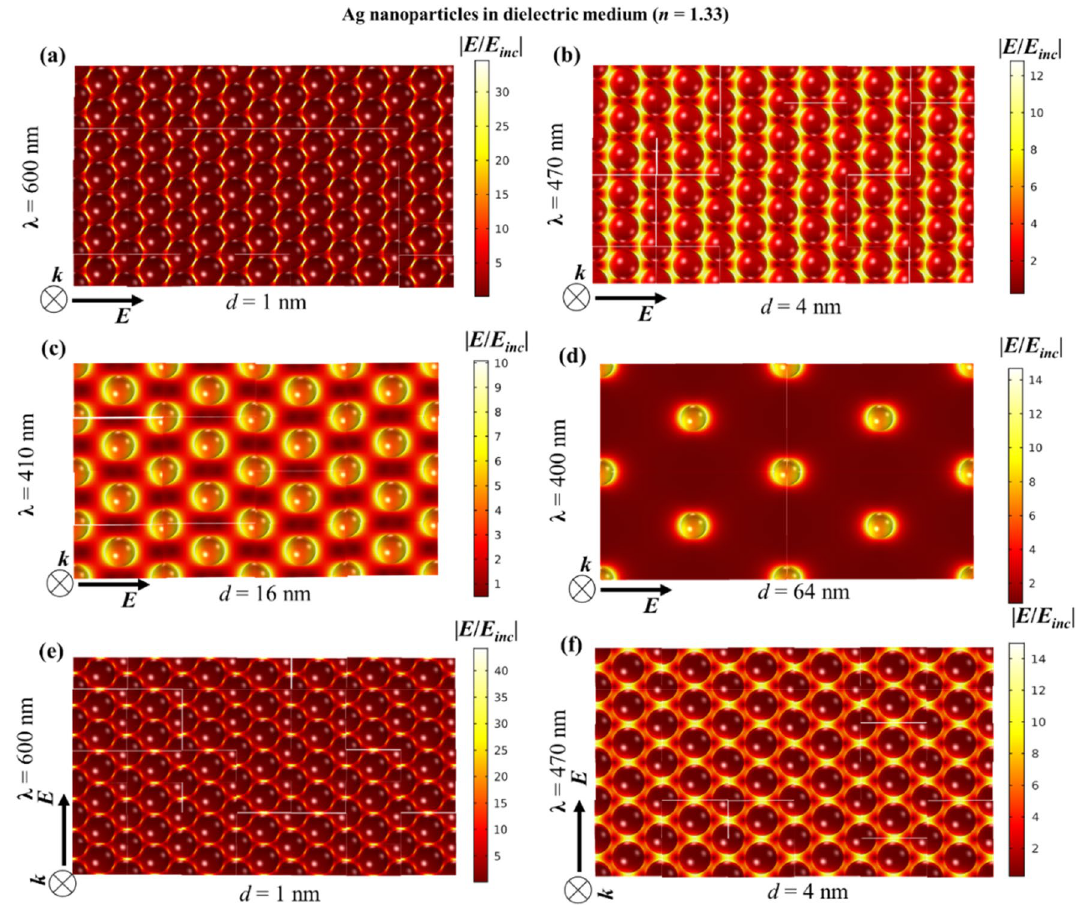
Figure 8. Near-field enhancement w.r.t. the incident field for 2D hexagonal monolayer array of 20 nm Ag nanoparticle in dielectric medium ( n = 1.33) for different interparticle gaps, d : ( a ) 1 nm, ( b ) 4 nm, ( c ) 16 nm and ( d ) 64 nm. ( e , f ) Shows the near-field profiles at vertical polarization for interparticle gaps 1 and 4 nm respectively. At normal incidence i.e. θ = 0°, ( a – d ) are for horizontal polarization i.e. φ = 0° and vertical polarization i.e. φ =